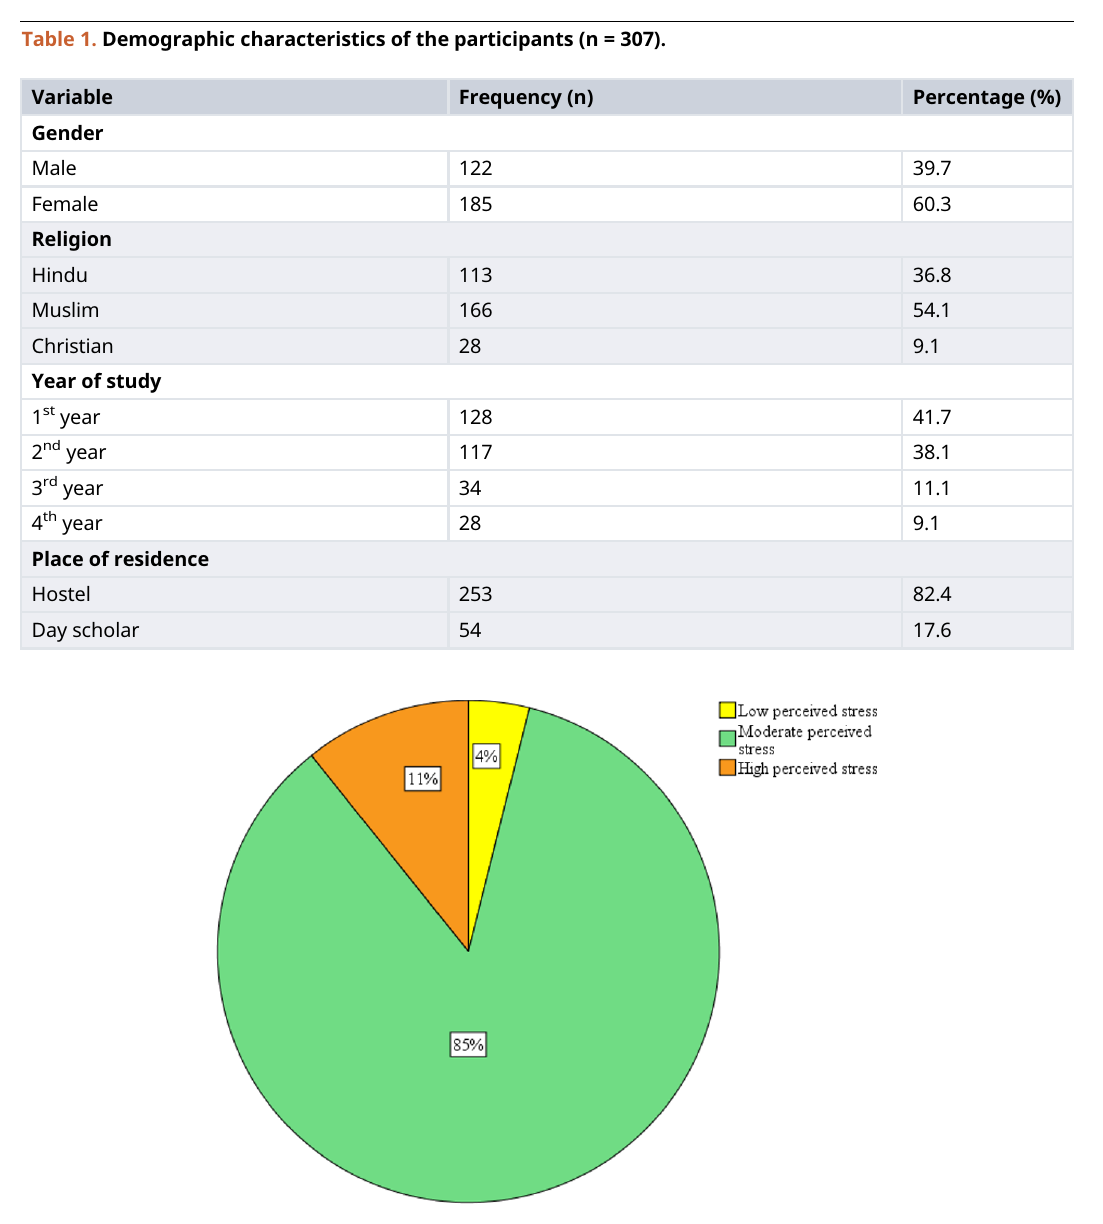
Figure 1. Stress level among medical